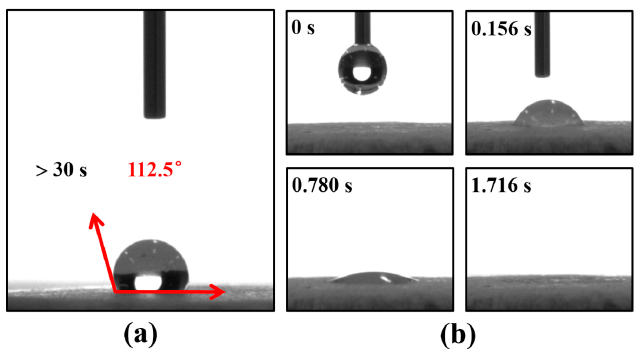
Figure 7. Water contact angle (WCA) of scaffolds for P 80-20 ( a ) before and ( b ) after alkaline modification.